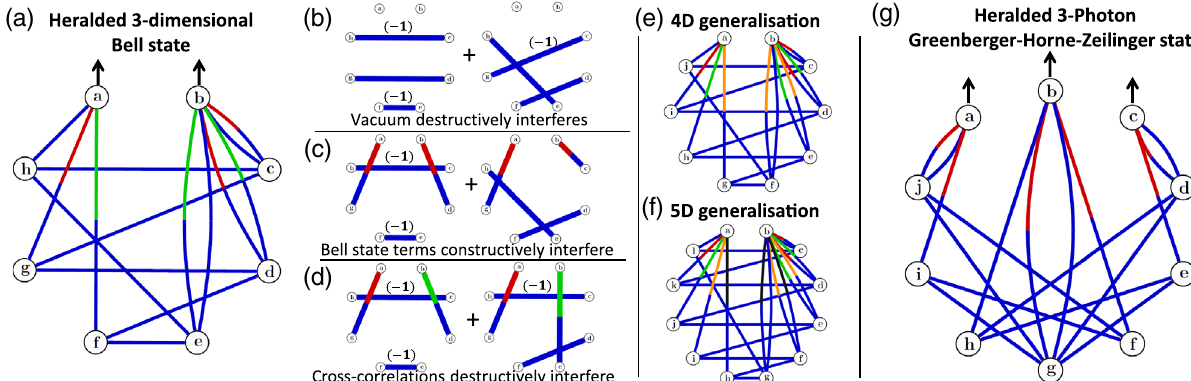
FIG. 4. Heralded entangled states. (a) Optimized graph for a heralded three-dimensionally entangled Bell state with photons in a and b containing a Bell state if detectors in c – h click, which requires eight photons in total. The crucial insight is the destructive interference of the undesired heralded vacuum term. (b) Each of the two subgraphs heralds the vacuum. The overall weight of the two subgraphs differs only in sign, leading to destructive interference. (c) With the same phase setting, all terms of the Bell state constructively interfere, such as j 1 ; 1 i , and all cross-correlation terms cancel, such as j 1 ; 2 i in (d). This solution can immediately be generalized to arbitrary high- dimensional Bell states; see (e) and (f). (g) Solution for a heralded two-dimensional GHZ state in a – c , with triggers in d – j , requiring ten photons. The algorithm identifies a highly symmetric solution that destructively interferes lower-order eight-photon